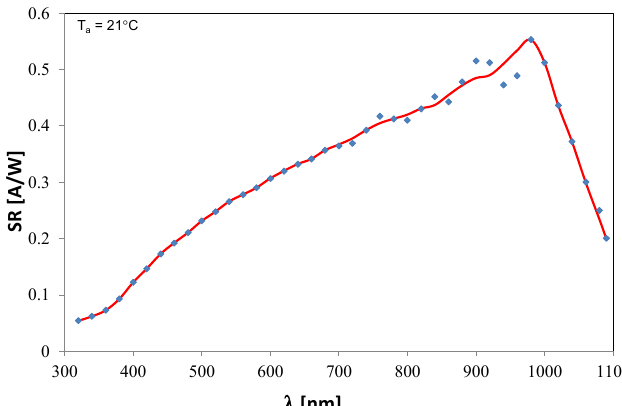
Figure 5. The measured spectral response of the tested solar cell in room temperature.